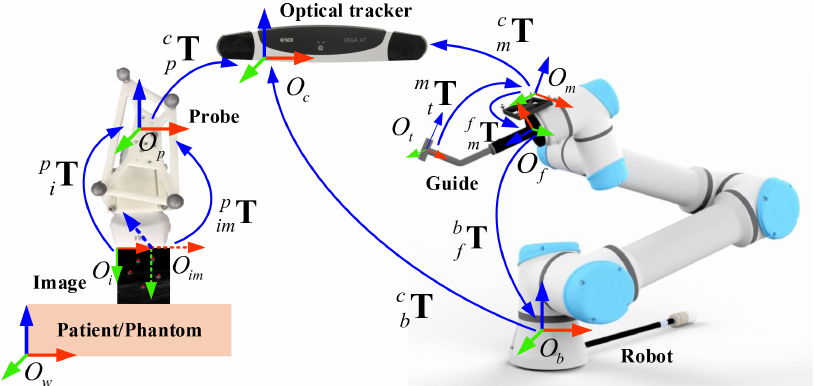
Figure 1. The involved coordinate systems in our robot-assisted US-guided biopsy system. During a needle biopsy procedure, the pose of the guide is adjusted to align with the biopsy trajectory planned in an acquired US image. See the main text for detailed